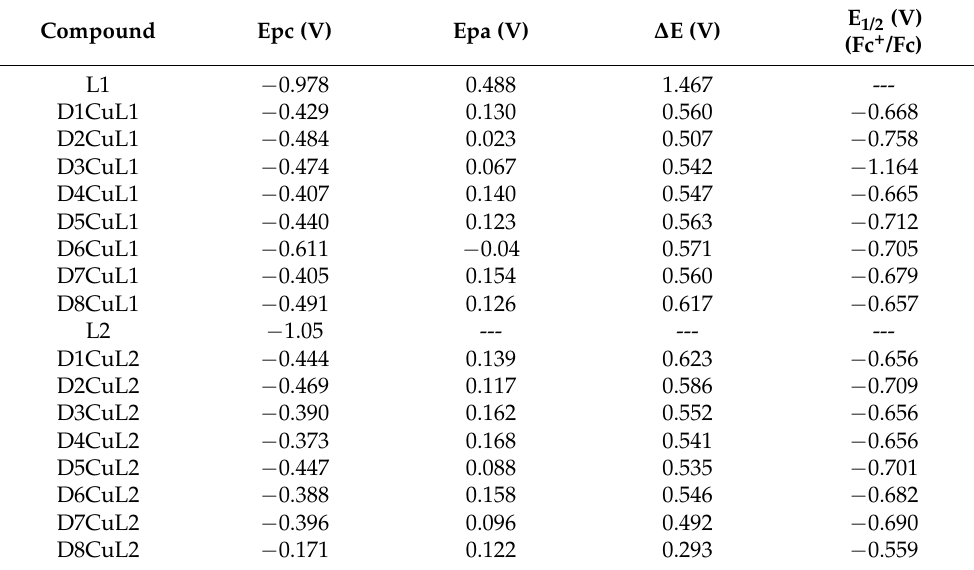
Table 3. Summary of cyclic voltametric parameters for copper(II) coordination compounds.